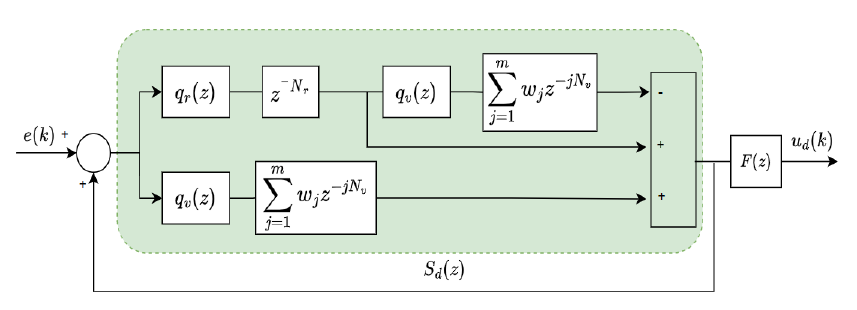
Figure 2. Block diagram of the plug − in DIMRC system.